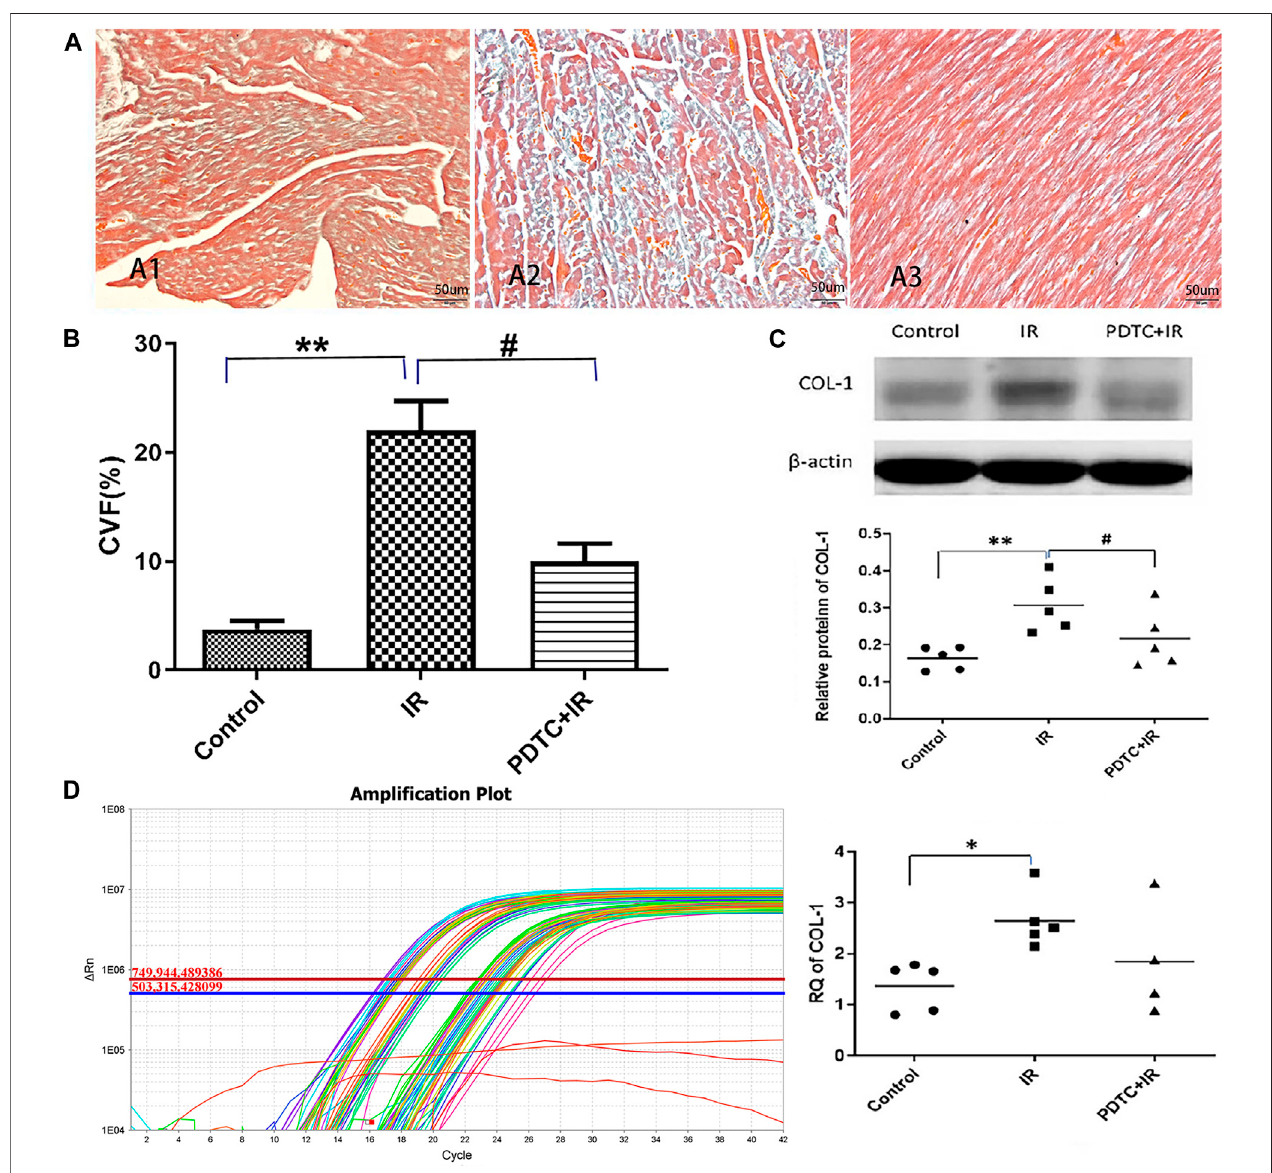
FIGURE4| EffectsofPDTCtreatmentonradiation-inducedmyocardial fi brosis. (A) Transversesectioninthemyocardialofrats via Masson ’ strichromestainingfor the observation of cardiac fi brosis (×200). All the collagen fi bers were stained blue. (A1) Normal appearance in the control group. (A2) Damage characterized by myocardial interstitial fi brosis in the irradiation group. (A3) Little of collagen deposited at myocardial interstitial tissue in the PDTC + irradiation group. (B) Quantitative analysisshowingcollagenvolumefraction(CVF)ineachgroup. (C) ExpressionofCOL-1wasrevealedbyWesternblotineachgroup. (D) ExpressionofCOL-1was revealed by qPCR in each group. n = 5 for each group. * p < 0.05 for irradiation vs. control group; ** p < 0.01 for irradiation vs. control group; # p < 0.05 for PDTC + irradiation vs. irradiation group.